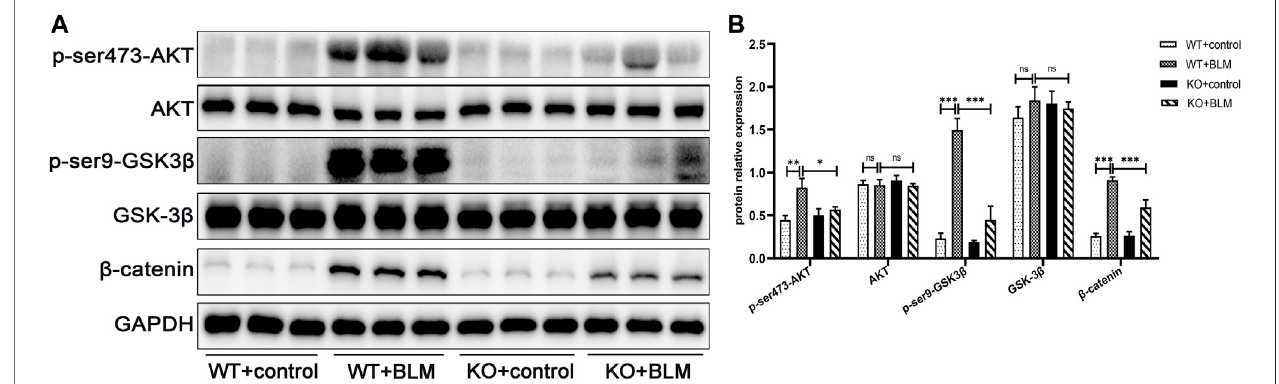
FIGURE 4 | Dec1 KO suppresses the activation of the PI3K/AKT/GSK-3 β / β -catenin signaling pathway in the BLM-induced PF murine model. WT and KO mice weretreatedwithasingleintratrachealinjection ofBLM(2.5 mg/kg)orsalinefor21days (A) Theproteinexpressionofp-ser473-AKT,AKT,p-ser9-GSK3 β ,GSK-3 β and β -catenin in the lung tissues of mice were detected by western blotting. (B) Statistical analysis of relative expression levels of proteins in A. n = 6. Data are shown as the mean ± SEM. Statistical analysis was performed by one-way ANOVA. * p < 0.05, ** p < 0.01, *** p < 0.001, ns p >